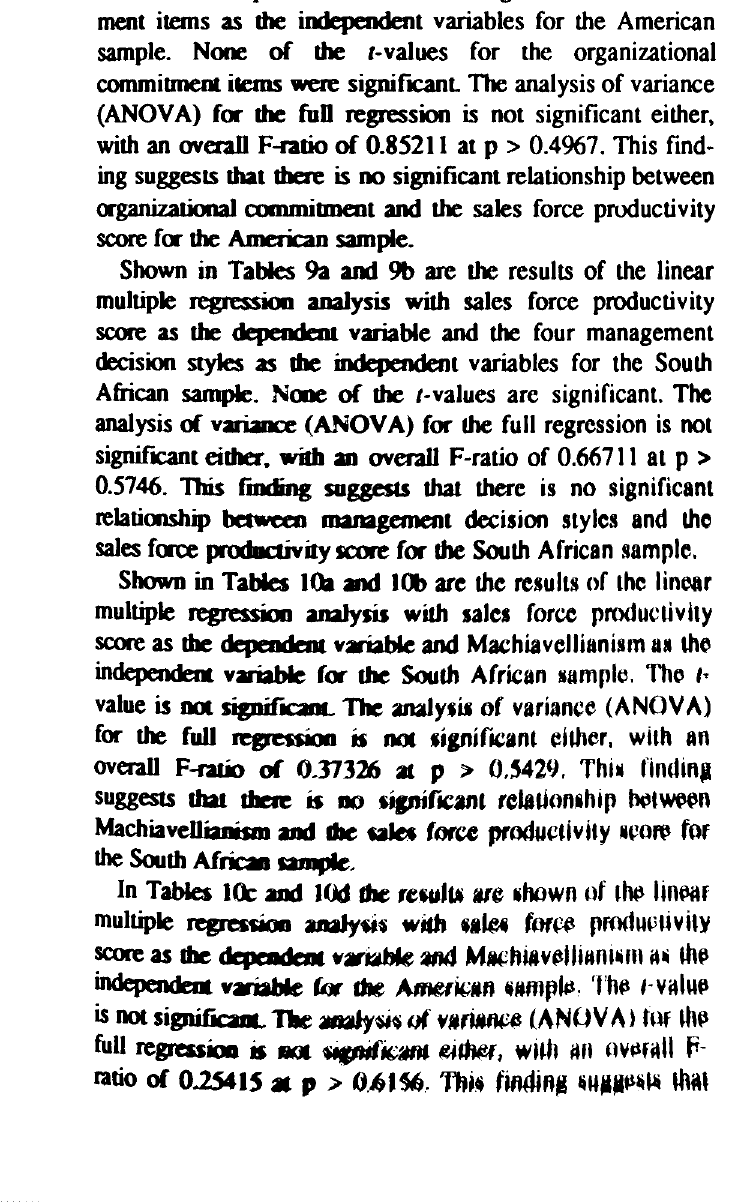
Table 9c Management decision styles & sales force productivity score: estimated regression coefficinets, ,. test values & coefficient of multiple determination -